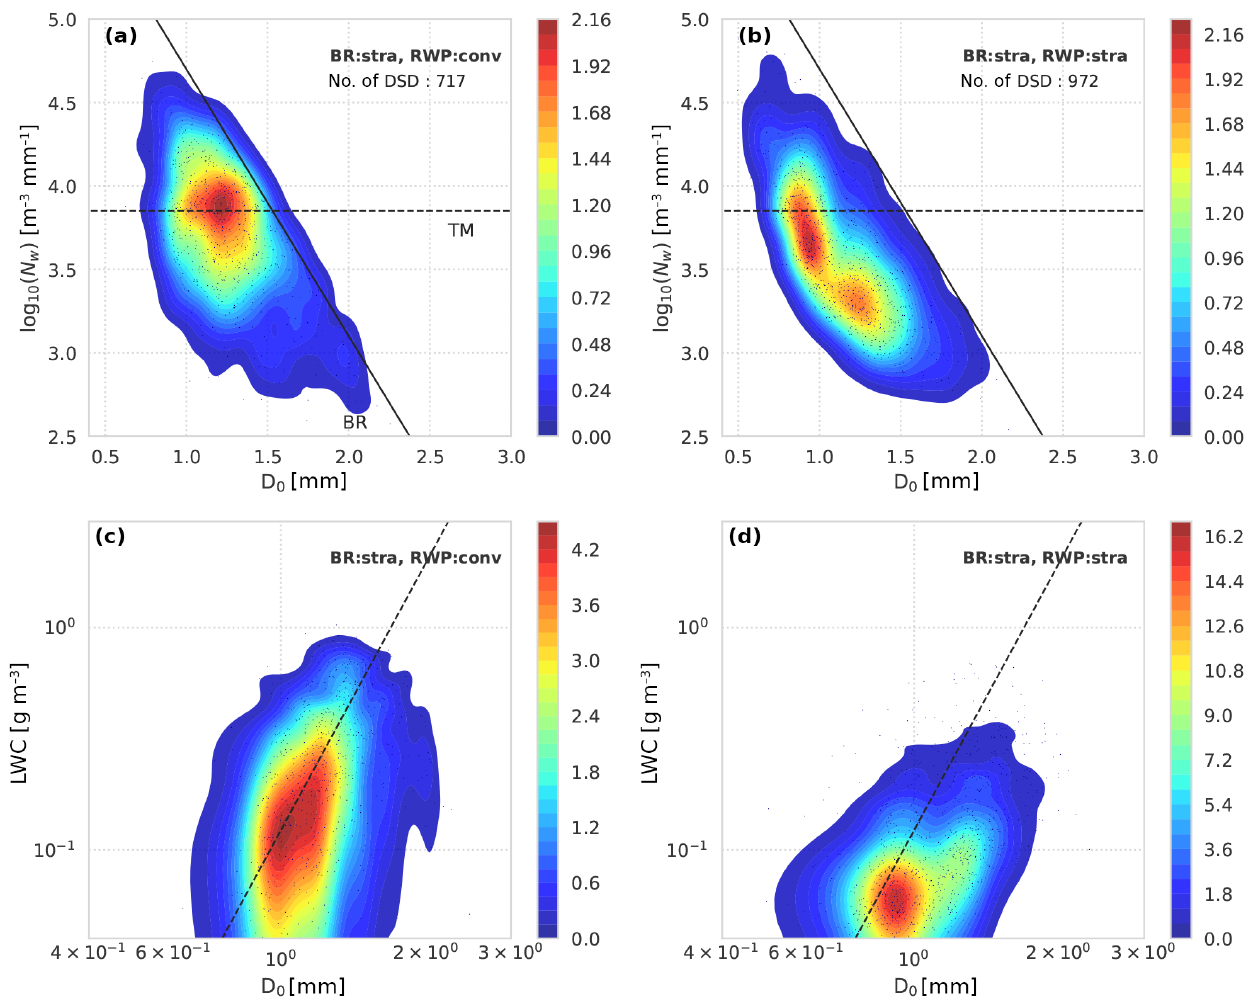
Figure 8. Scatter plots of log 10 ( N w ) versus D 0 and LWC versus D 0 for BR-based stratiform DSDs (density in colors). DSDs identified as convective and stratiform by the RWP are shown in (a, c) and (b, d)